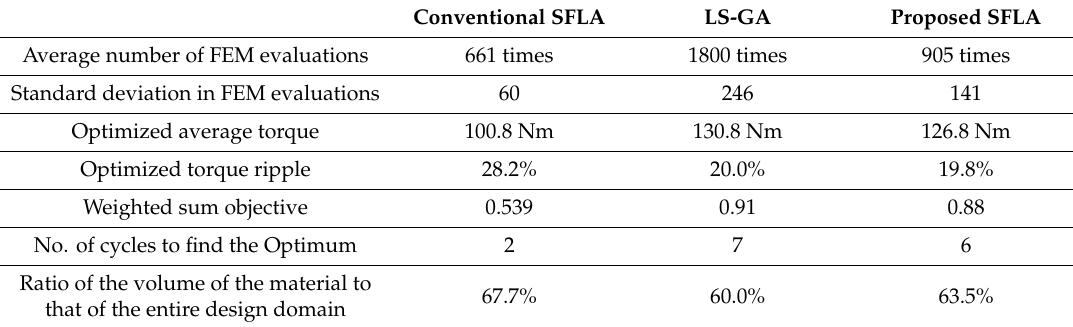
Table 3. Summary of optimization performances of all three